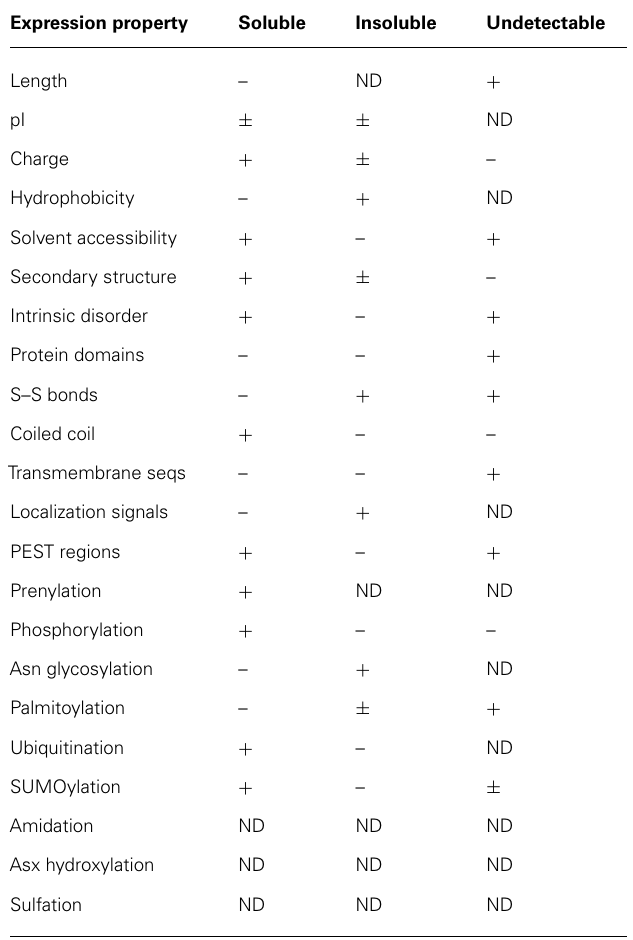
Table 1 | Correlations of cell-free protein expression with calculated and predicted properties of amino acid